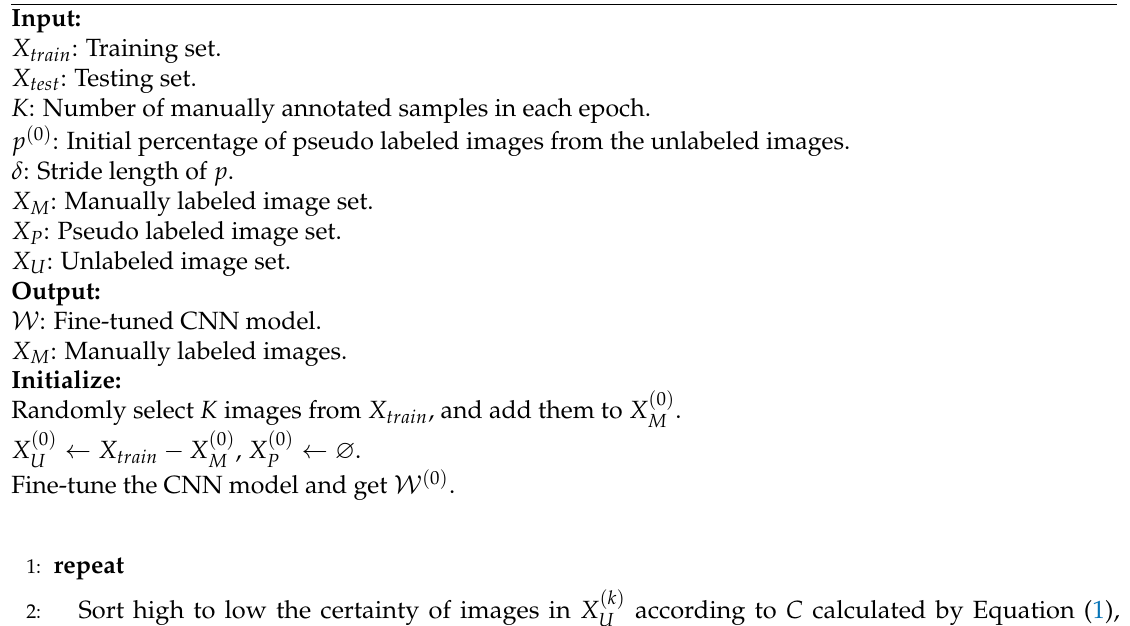
Algorithm 1 Active deep learning for multichannel